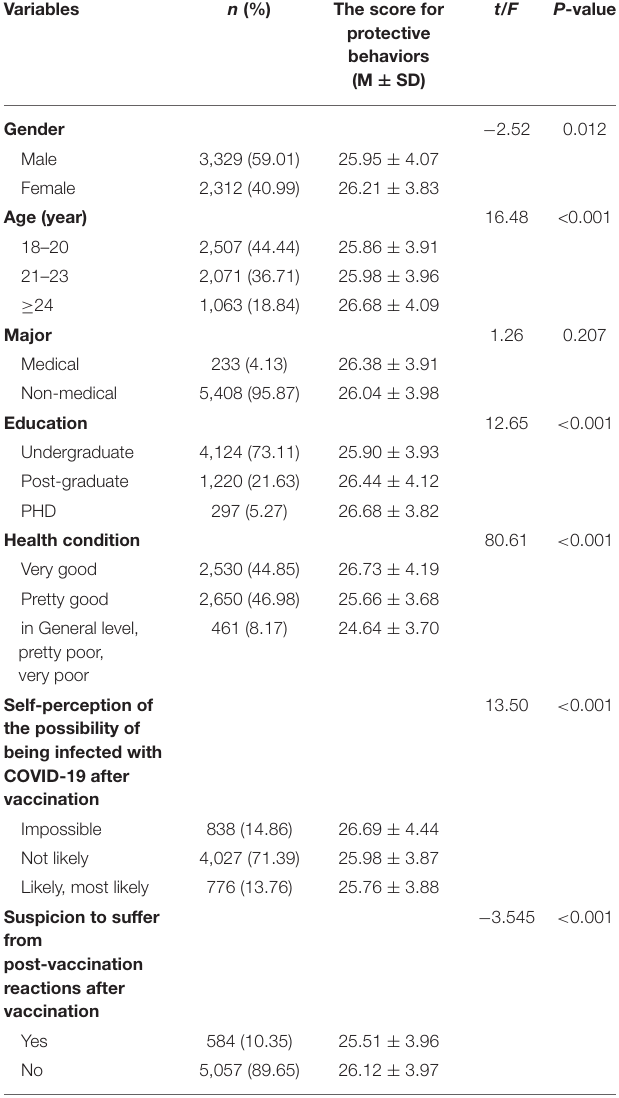
TABLE 1 | Sociodemographic profiles and univariate analysis for protective behaviors following vaccination ( N = 5,641).